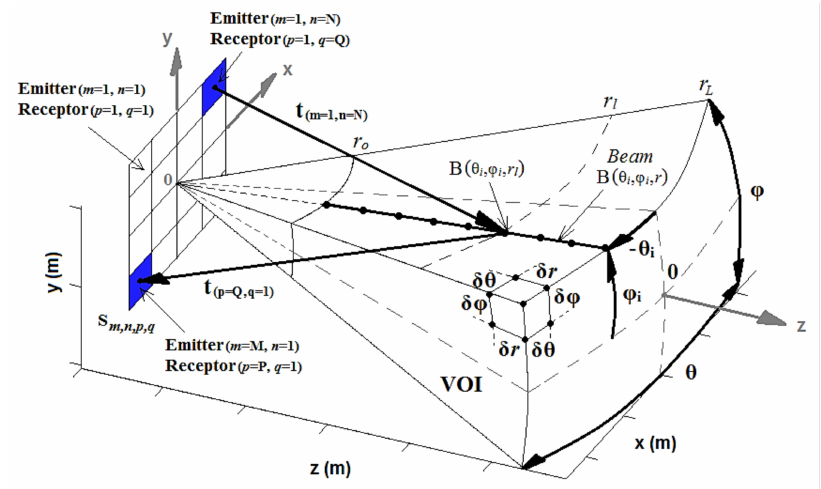
Figure 17. Coordinates system of the “pyramidal” volume of interest (VOI), where the 3-D images are